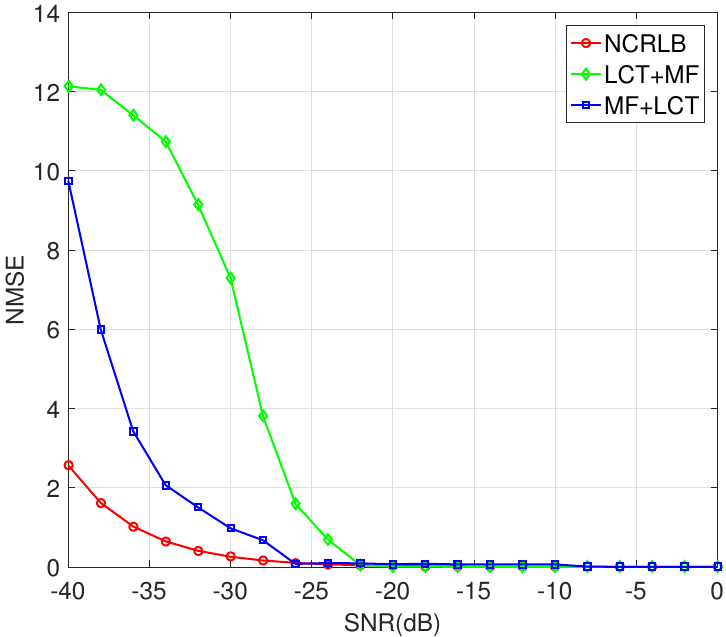
Figure 15. Height estimation performance with different SNRs.